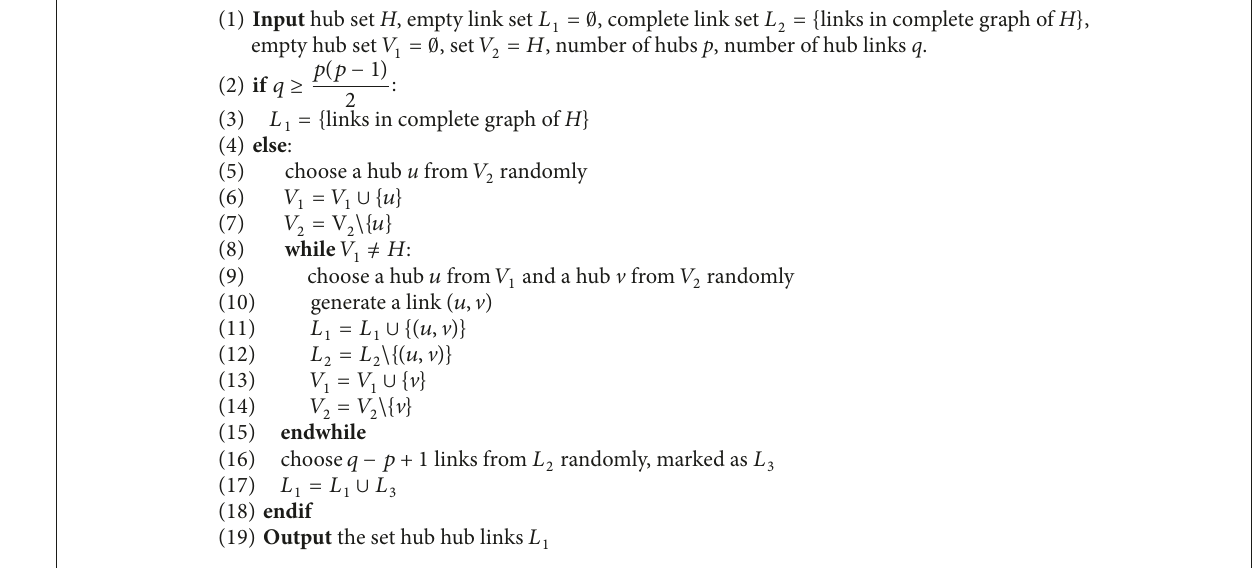
Algorithm 1: Random Prim algorithm for finding a connective hub network.